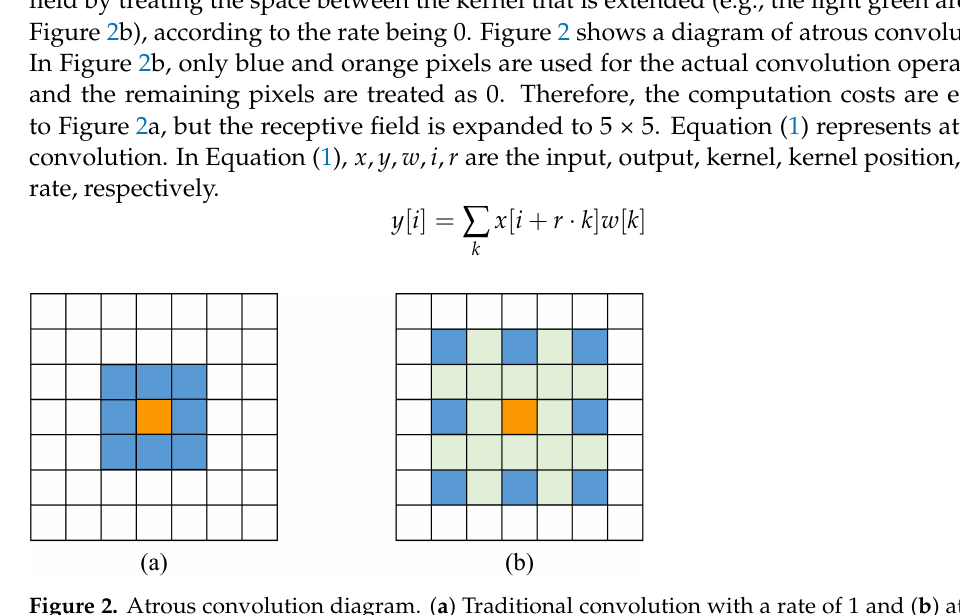
Figure 2. Atrous convolution diagram. ( a ) Traditional convolution with a rate of 1 and ( b ) atrous convolution with a rate of 2.